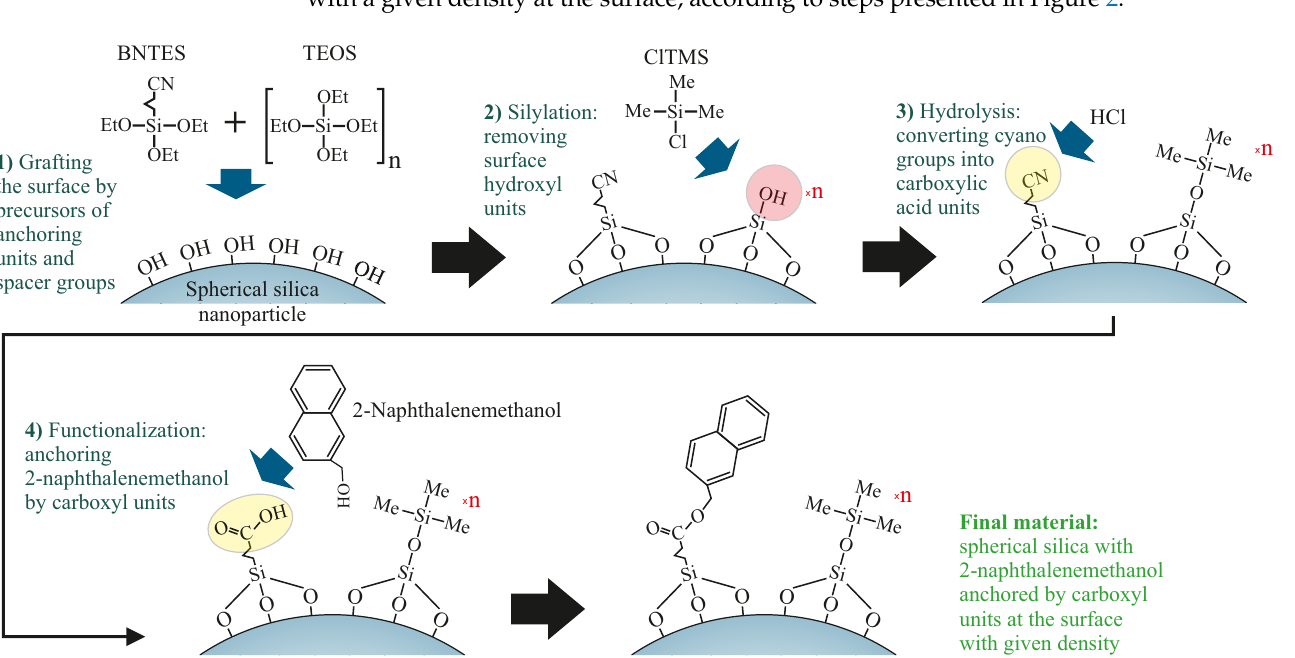
Figure 2. A diagram of the route of the synthesis of the spherical silica functionalized by 2-naphthalene methanol with a designed density of functional units. The number n denotes the number of tetraethyl orthosilicate (TEOS) in moles per single mole of the precursor of functional units (butyronitriletriethoxysilane—BNTES) and determines the density. Other abbreviations: TEOS—tetraethyl orthosilicate, ClTMS—chlorotrimethylsilane, Me—methyl groups, Et—ethyl